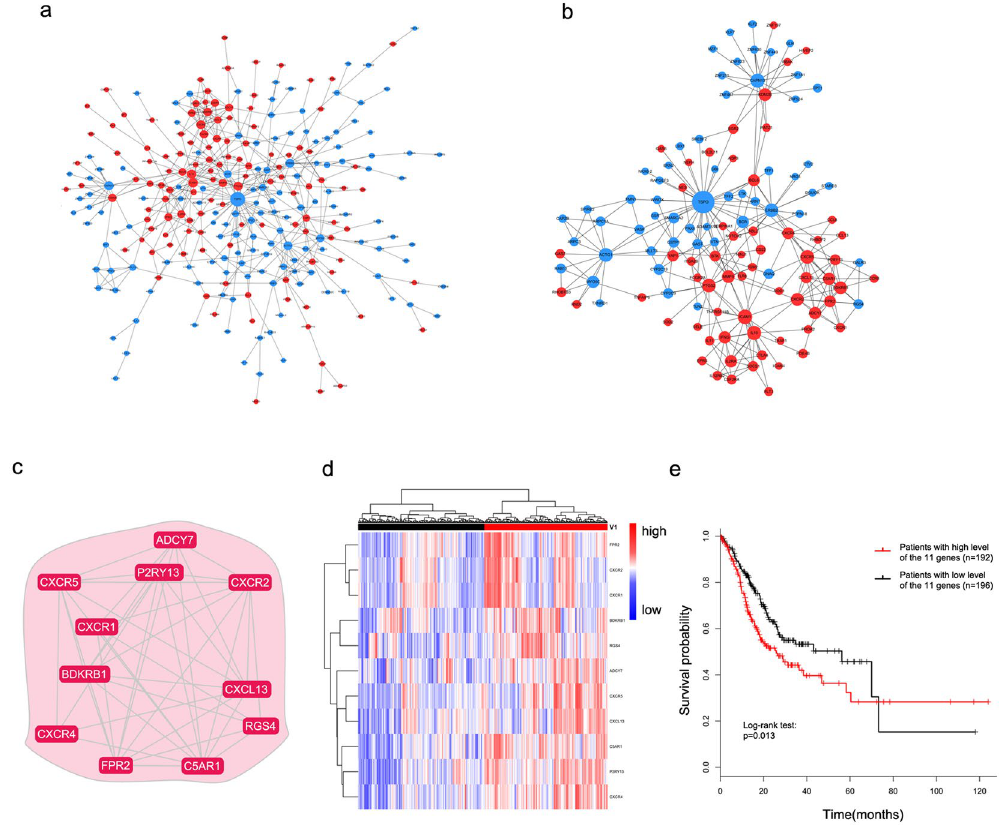
Figure 6. Identification of an 11-gene module related to the overall survival of GC patients using the network- based method. ( a ) The maximal subnetwork contained 265 nodes and 462 edges. ( b ) The hub network contained 12 nodes in the top 5%, with respect to degree and their first neighbour nodes. ( c ) The 11-gene module was identified using the Clique Percolation Method (k = 5). ( d ) The 388 TCGA gastric tumour patients were divided into two groups according to the expression levels of the 11 genes using unsupervised hierarchical clustering. The expression levels of these genes are illustrated as a colour spectrum, with red, white and blue representing high, medium and low expression, respectively. ( e ) Kaplan-Meier survival curves and log-rank tests were used to estimate the overall survival of the two patient groups, p <